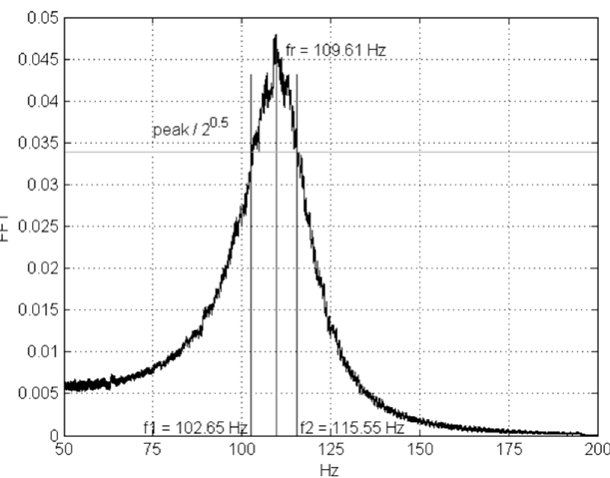
(cid:104) (cid:105) (cid:3118) ] , kg · m 2 , rad (cid:2928)(cid:2911)(cid:2914) (cid:3118) ] , (cid:2928)(cid:2911)(cid:2914) − f 1 . 2 f r